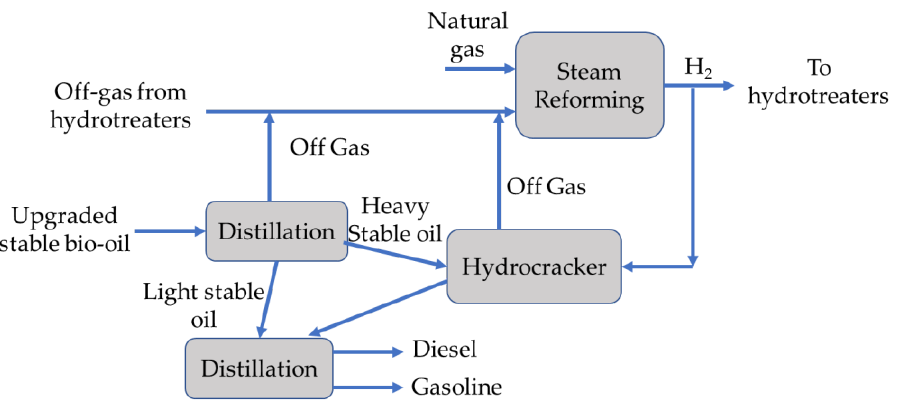
Figure 4. Block diagram for hydrocracking and product separation [74].